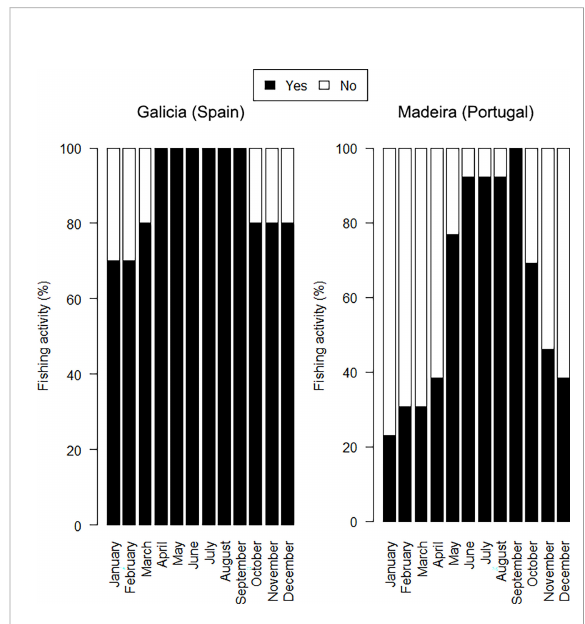
FIGURE 2 Annual cycle of activity of recreational fi shing charter boat companies in Spain (Galicia) and Portugal (Madeira archipelago). The percentage of active boats in each month is shown.